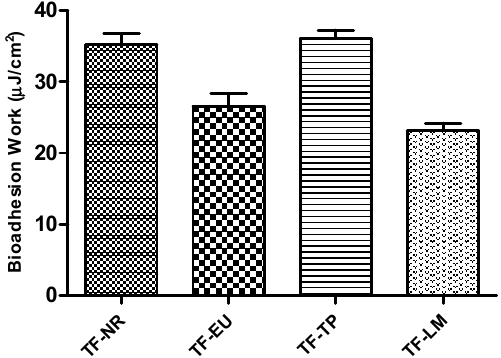
Figure 4. In vitro adhesion force of transdermal